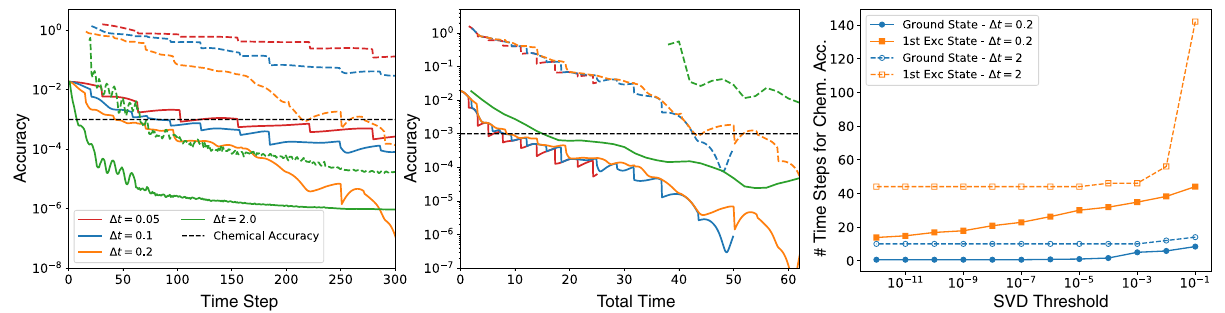
FIG. 9. Ground- (solid) and excited-state (dashed) energies of LiH as a function of the time step (left) and total simulation time (middle). The initial reference vector is the Hartree-Fock state. We use the 3-21g basis set that has 4 electrons and 11 orbitals. The SVD cutoff is 10 − 1 for both the left and middle plots and the legend is the same for both. The right figure shows the total time to reach chemical accuracy as a function of SVD.